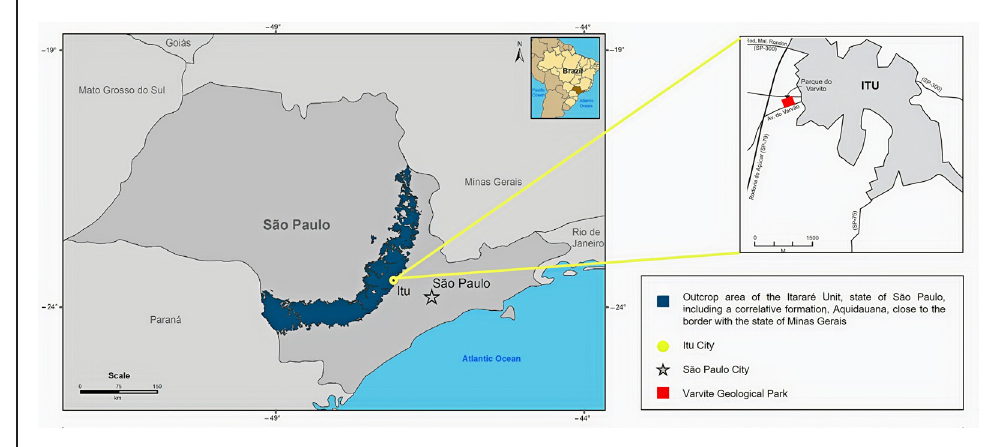
FIGURE 1 . Varvite Geological Park’s location (adapted from Guimarães et al. 2018 and Rocha-Campos